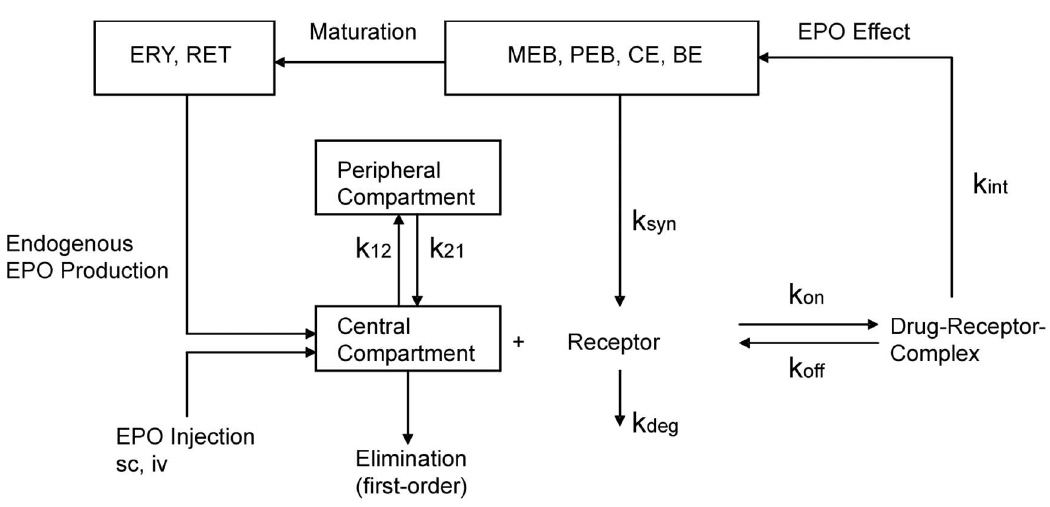
Figure 2. Pharmacokinetic model of EPO. Boxes represent compartments. Arrows represent actions or flows. The pharmacokinetic model of erythropoietin was adapted from [13]. doi:10.1371/journal.pone.0065630.g002 PLOS ONE |